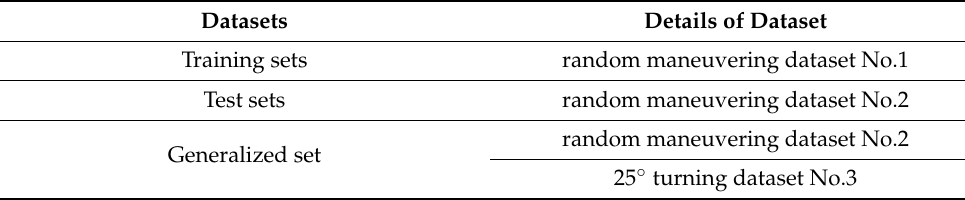
Table 3. Datasets for training, validation, and testing.